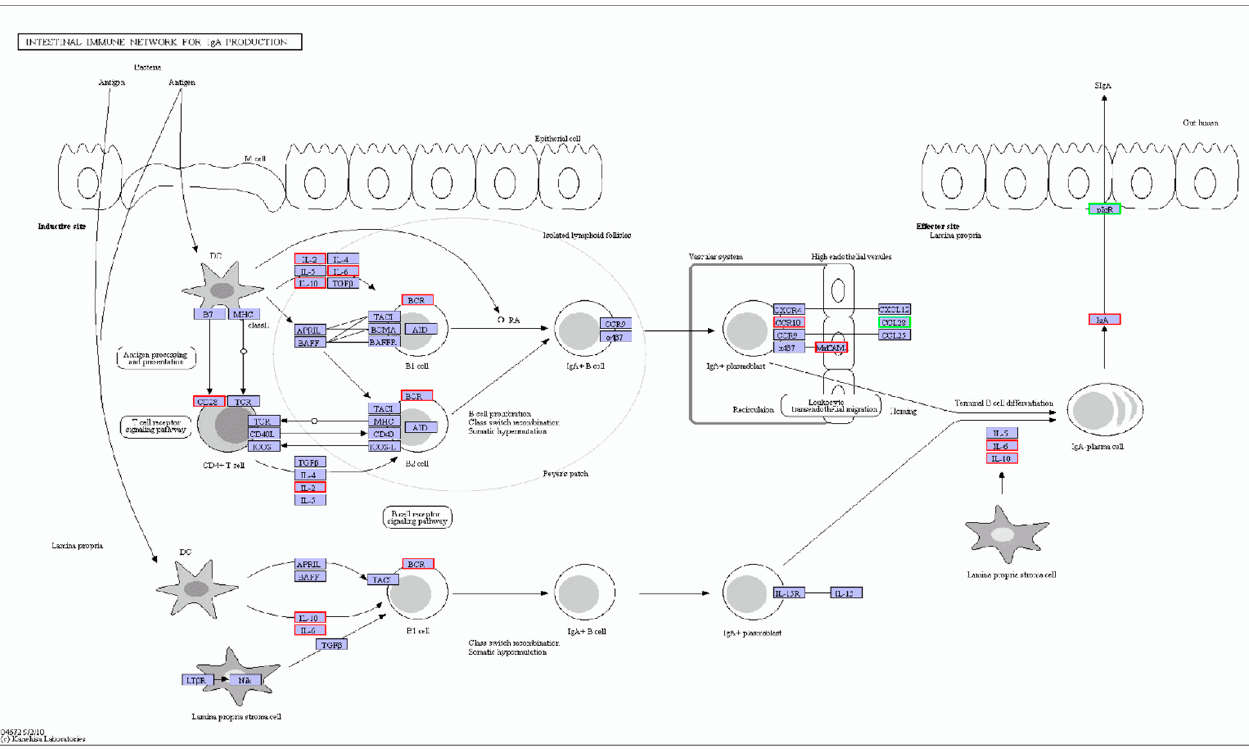
Figure 5. IgA-production-signaling pathway. Green, significantly downregulated DEGs. Red, significantly upregulated DEGs.